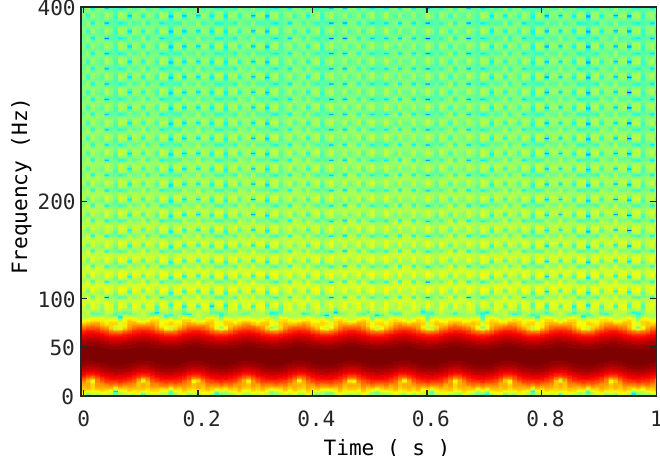
Figure 11. Spectrogram of ξ y ( t ) in non-homogeneous